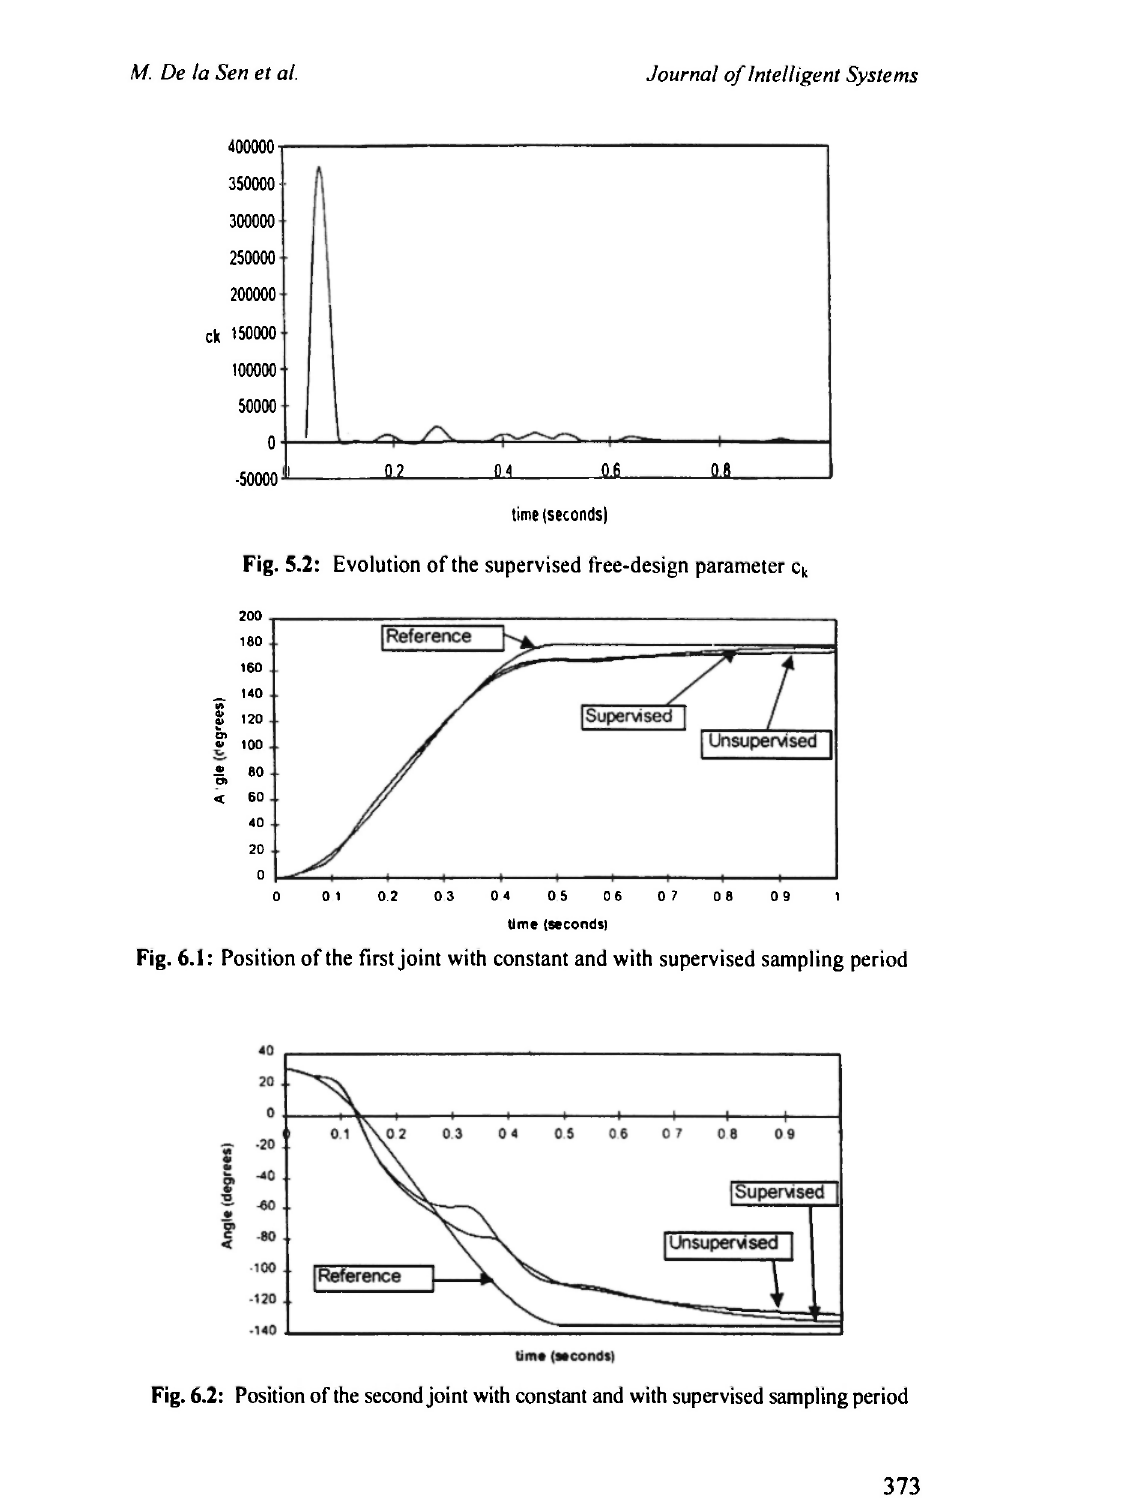
Fig. 6.1: Position of the first joint with constant and with supervised sampling period